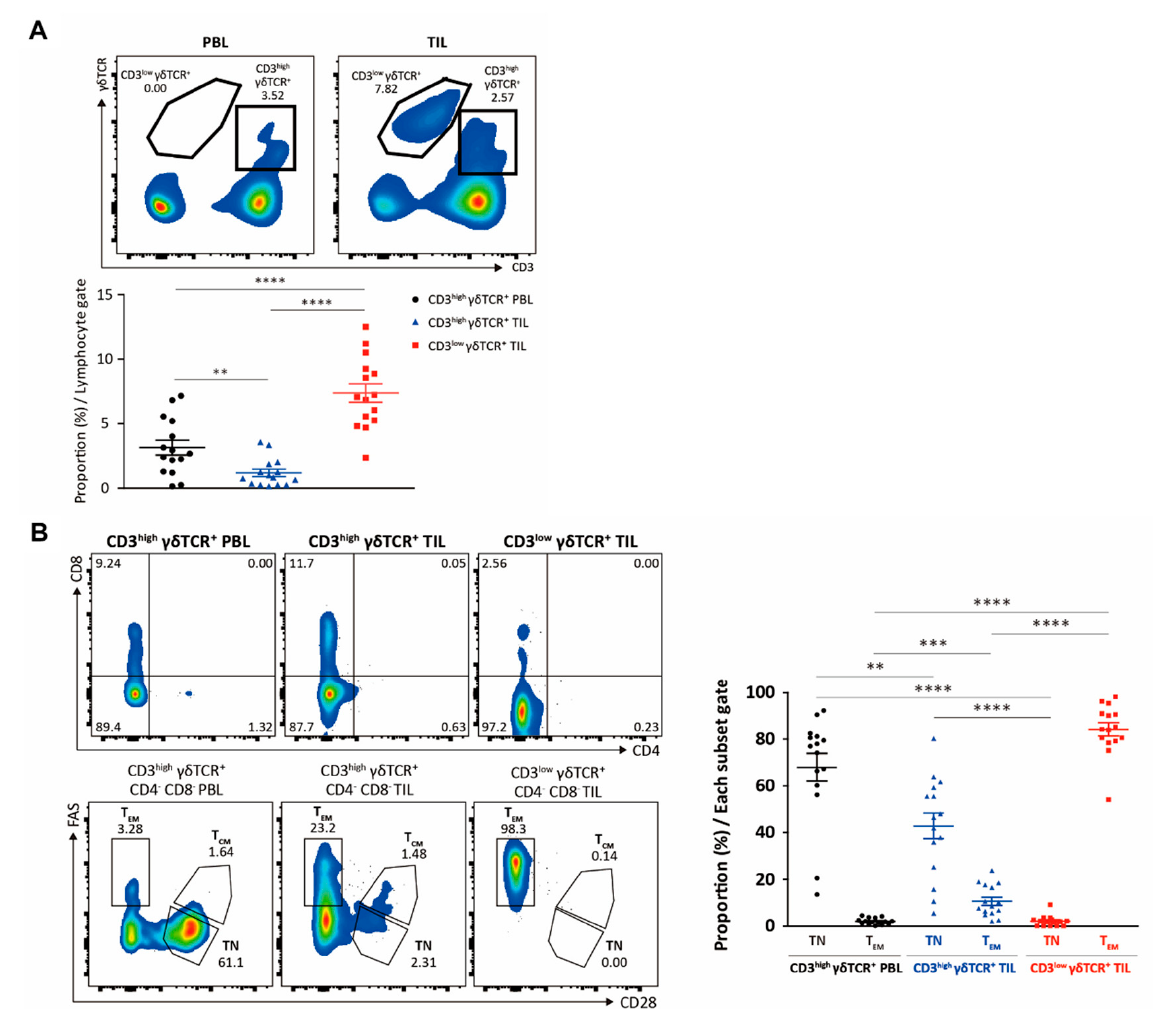
Figure 2. Analysis of peripheral blood (PB) and tumor-infiltrating lymphocytes (TILs). ( A ) PB and TILs were analyzed for γδ TCR and CD3. ( B ) CD3 high γδ T cells from peripheral blood lymphocytes (PBLs) and TILs and CD3 low γδ T cells from TILs were analyzed for CD4 and CD8, as well as for FAS and CD28. ** p < 0.01, *** p < 0.001 , and **** p < 0.0001.